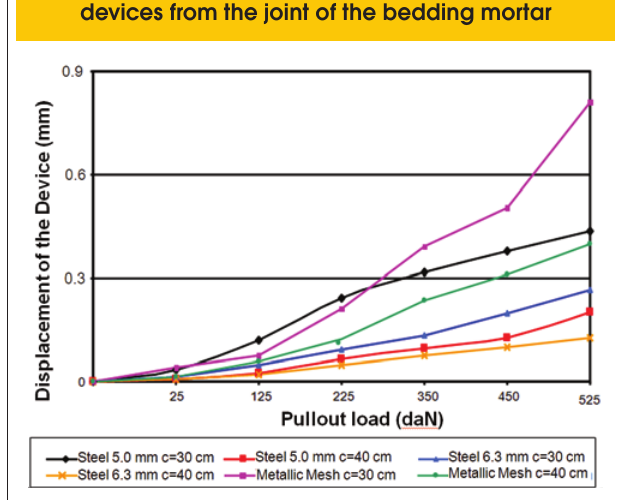
Figure 9 – Photo of the test for evaluation Figure 10 – Results of the pullout test of the connecting